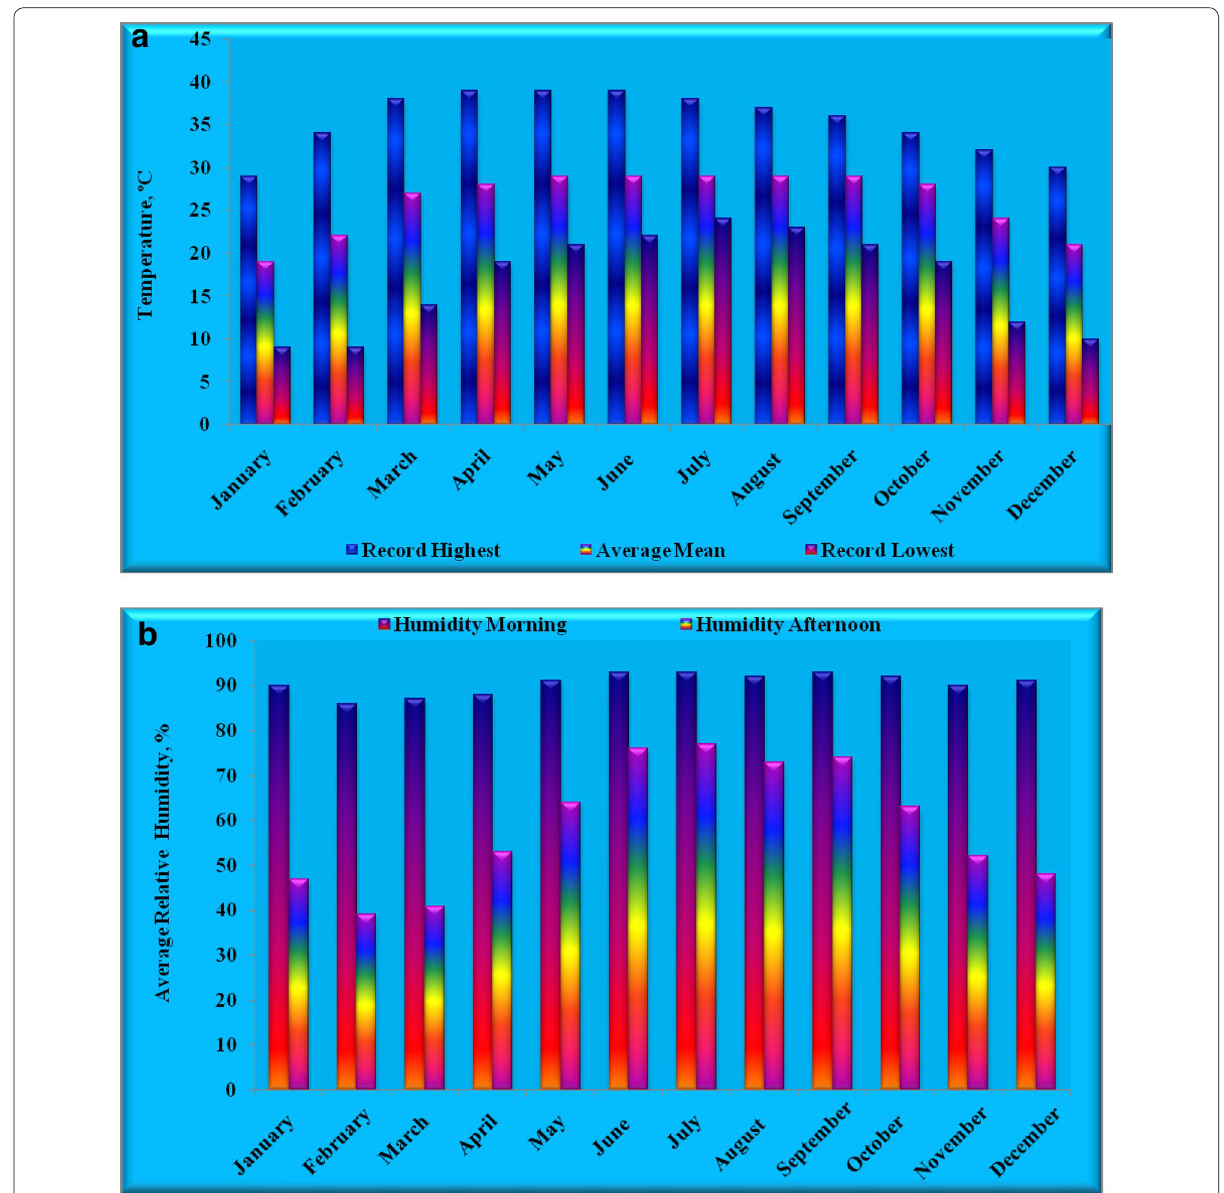
Fig. 2 a Column diagram of monthly recorded highest, lowest and average temperature. b Column diagram of monthly recorded average relative humidity % in morning and in